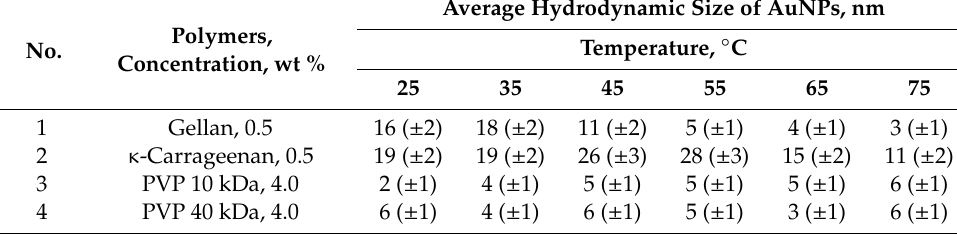
Figure 13. UV – Vis spectra of AuNPs synthesized and stabilized using 0.5 wt % gellan at different temperatures. [HAuCl 4 ] = 0.01 mM. Table 4. Temperature-dependent average hydrodynamic size of AuNPs synthesized and stabilized using synthetic and natural polymers. The standard deviations are given in parentheses.